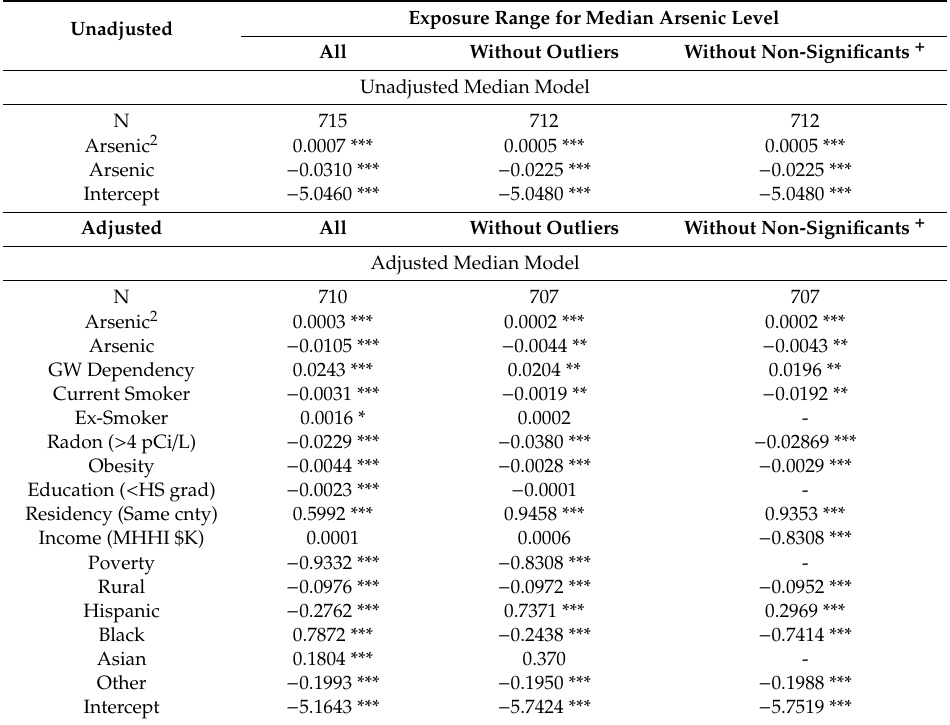
Table 2. Unadjusted and Adjusted Poisson Regression Models of Median Arsenic Exposure